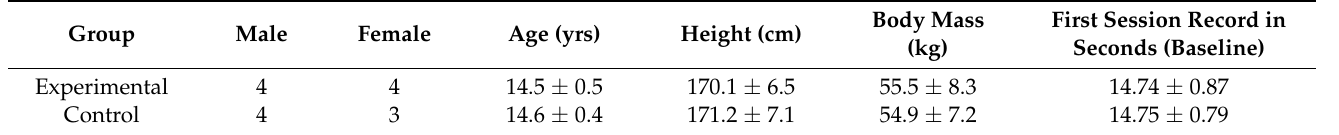
Table 1. Characteristics of the swimmers in the experimental and control groups. The swimmers were selected to have similar